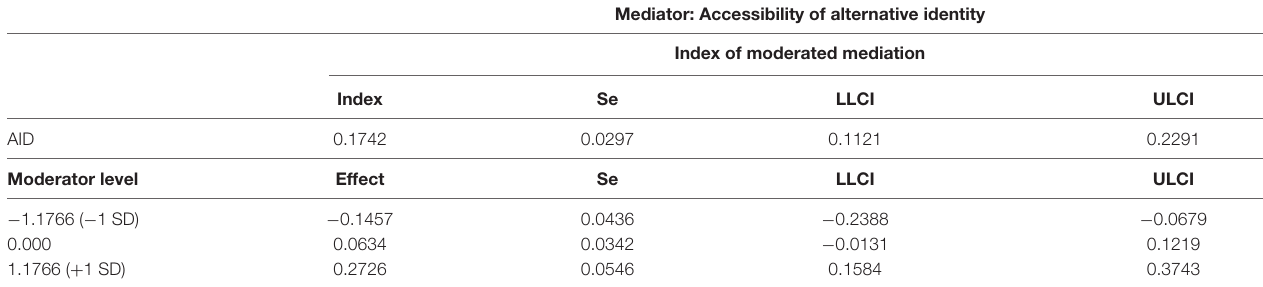
TABLE 6B | Results of the mediation effect of the accessibility of alternative identity under alternative identity discrepancy